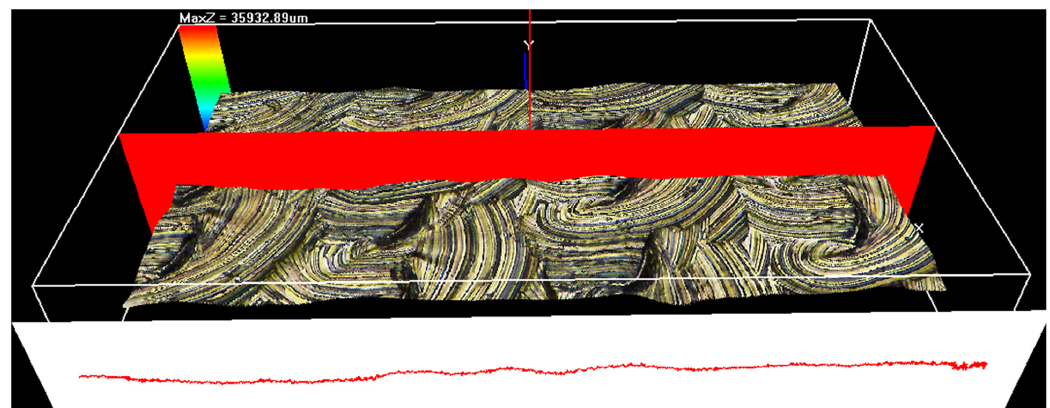
Figure 25. Workpiece surface topography machined by DACT with inclination angle of 0°.